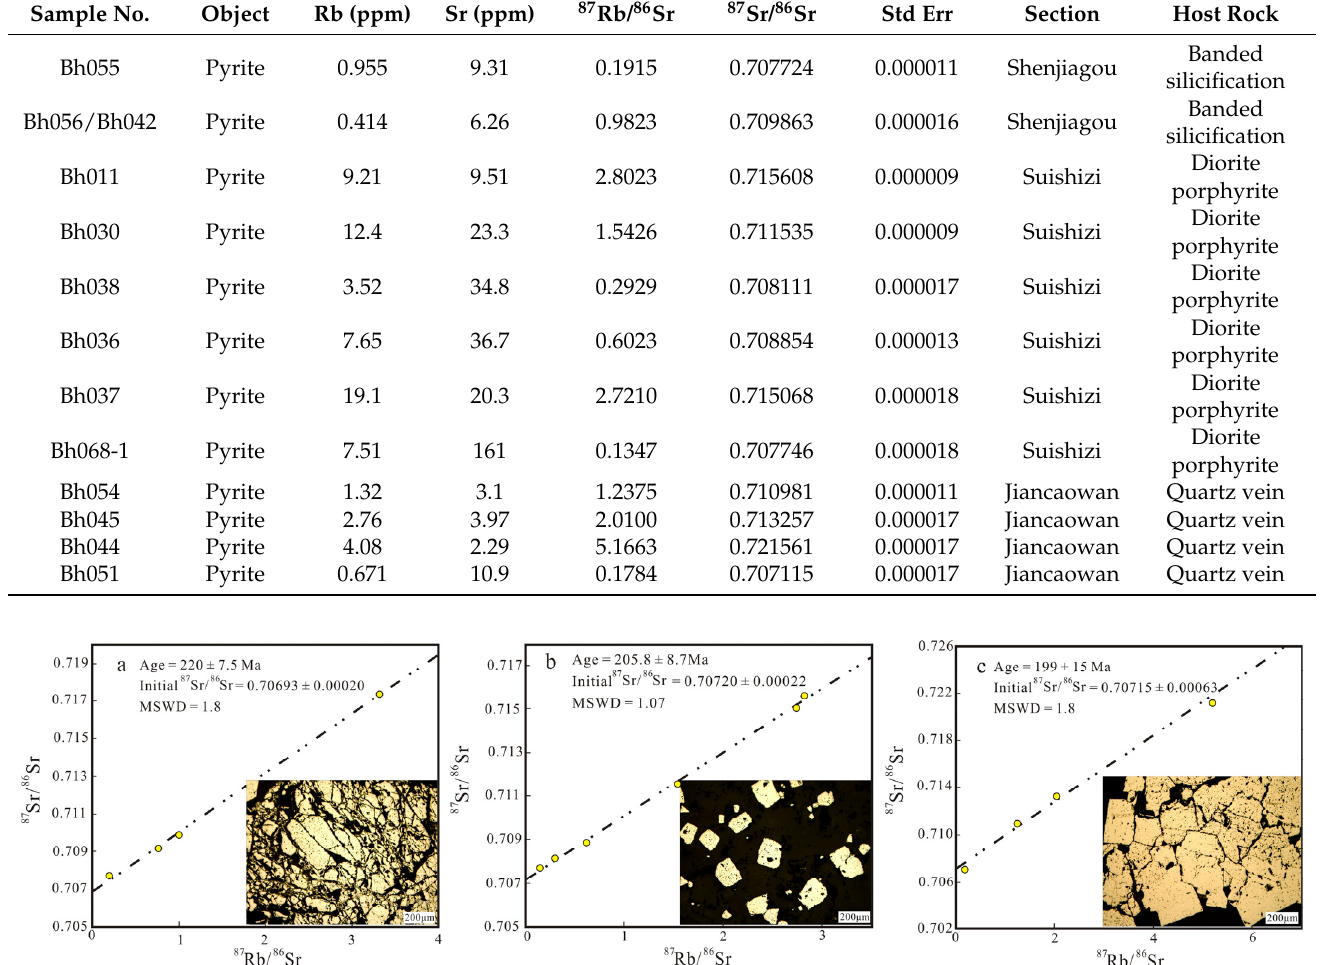
Figure 7. SHRIMP U–Pb Concordia diagram and CL images of zircons from the Tianzishan